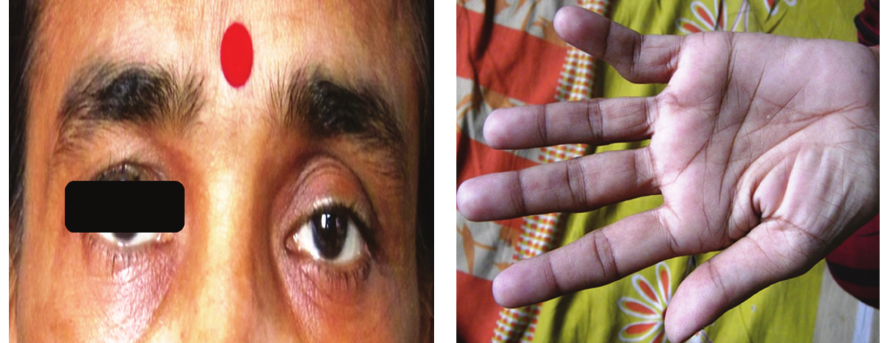
Figure 1: Photograph showing left sided partial ptosis and enophthalmos with wasting of hypothenar eminence of left